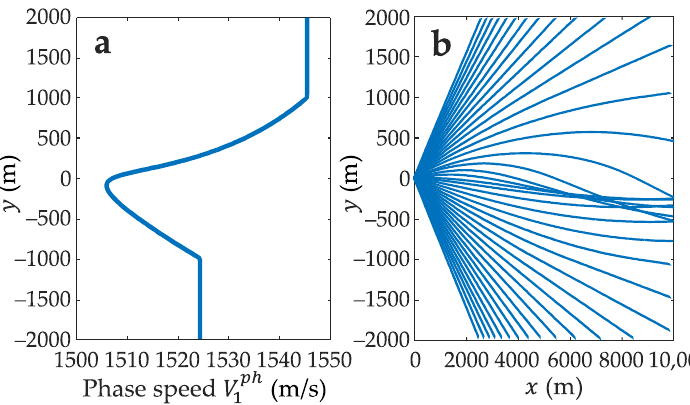
Figure 3. ( a ) Modal phase speed profile along the y -axis for the first mode at a frequency of 55 Hz and ( b ) the corresponding modal rays in the horizontal plane.